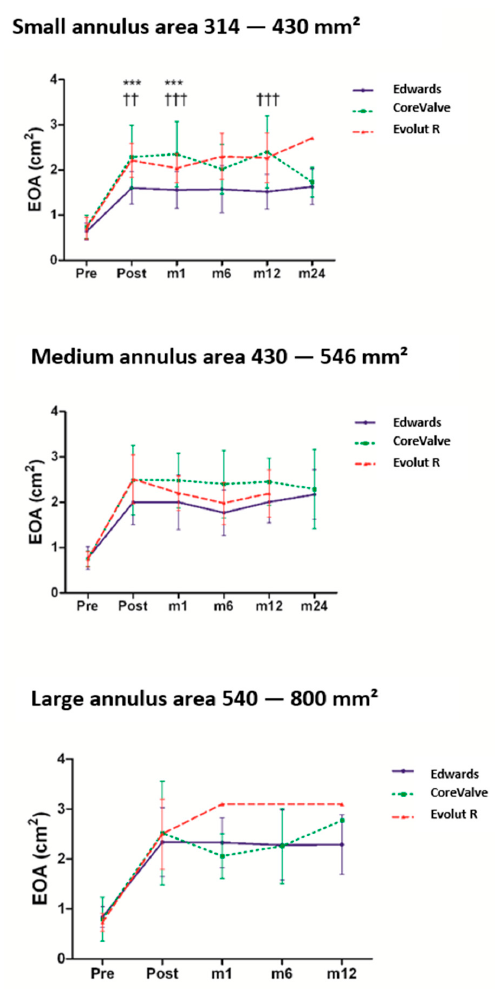
Figure 2. Temporal changes of effective orifice areas (EOAs) from the pre-implantation (pre) phase to the post-implantation (post) period—i.e., at 1, 6, 12, and 24 months (M1, M6, M12, and M24, respectively) of follow-up—in three groups of patients according to their aortic annulus area measured on CT images. *** p < 0.001 for Edwards Sapien S3 ® versus CoreValve ® . ††† p < 0.001 and †† p < 0.01 for Edwards Sapien S3 ® versus Evolut ® R.